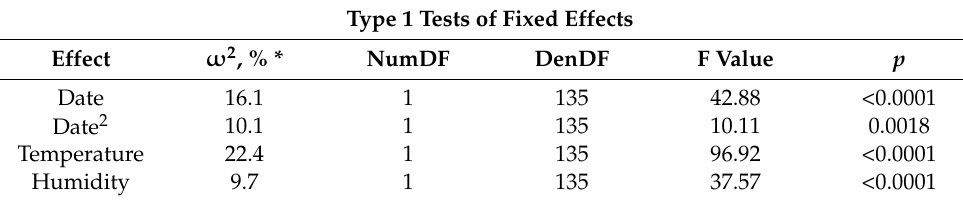
Table 4. Abundance (individuals in a trap per night, log-transformed) as a function of weather variables, a glmm model with ‘site’ (exact trap location) as a random factor. Type I analysis; defini- tive model obtained by backward elimination is presented. Switching the order of humidity and temperature in the model did not lead to qualitatively different results.